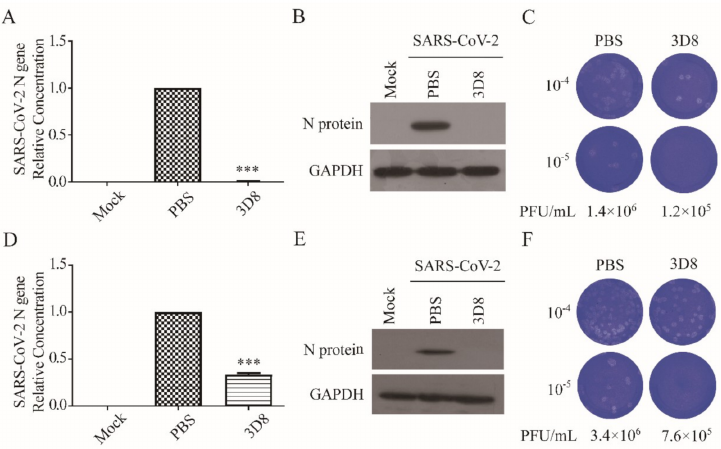
Figure 3. Prophylactic and therapeutic antiviral effects of 3D8 against severe acute respiratory syndrome coronavirus-2 (SARS-CoV-2). ( A ) Inhibition of SARS-CoV-2 by 3D8 in pretreated cell cultures. Vero E6 cells pretreated with 3D8 were infected with SARS-CoV-2. At 48 hpi, the cells were harvested, and the viral copy number was quantified based on the relative concentration of the N gene. ( B ) The N protein of SARS-CoV-2 was identified by Western blot. ( C ) Supernatants were harvested from 3D8-pretreated cell cultures infected with SARS-CoV-2, and the infectious viral titer was determined using a plaque assay. The clear zone indicates the plaque formation. ( D ) Inhibition of SARS-CoV-2 by 3D8 in post-treated cell cultures. Vero E6 cells were infected with SARS-CoV-2 at 2 hpi and treated with 3D8 for 48 hrs. The cells were harvested, and the viral copy number was quantified based on the relative concentration of the N gene. ( E ) The N protein of SARS-CoV-2 was identified by Western blot. ( F ) Supernatants were harvested from 3D8-post-treated cell cultures infected with SARS-CoV-2, and the infectious viral titer was determined using a plaque assay. Data presented here are representative of at least three independent experiments performed in